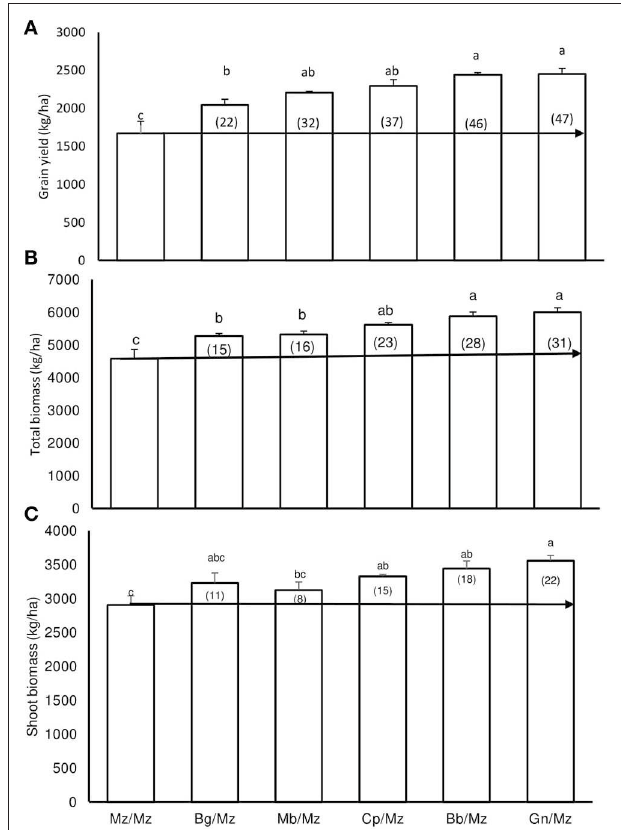
FIGURE 1 | A comparison of (A) grain yield, (B) whole-plant DM, and (C) shoot biomass of maize planted after maize with maize after legumes from zero-N plots at Nelspruit, Mpumalanga Province, in the 2012/2013 cropping season. Values in brackets represent % increases in yield of maize after legume relative to maize after maize as the preceding crop in zero-N plots. The horizontal line delineates increases in yield from zero-N plots caused by a preceding legume crop relative to a maize after maize monoculture. (Mz/Mz, maize after maize; Bg/Mz, maize after black gram; Mb/Mz, maize after mung bean; Cp/Mz, maize after cowpea; Bb/Mz, maize after Bambara bean; and Gn/Mz, maize after